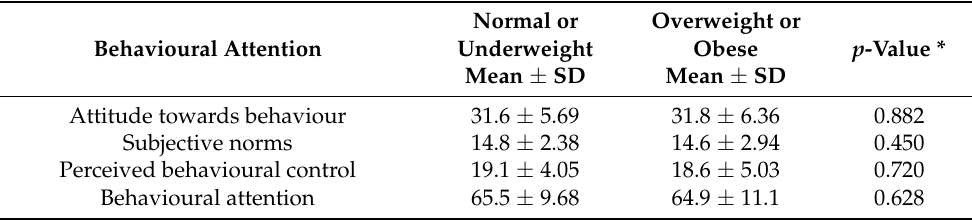
Table 4. Differences in the scores of the behavioural attention and its constructs according to BMI level ( n = 385).